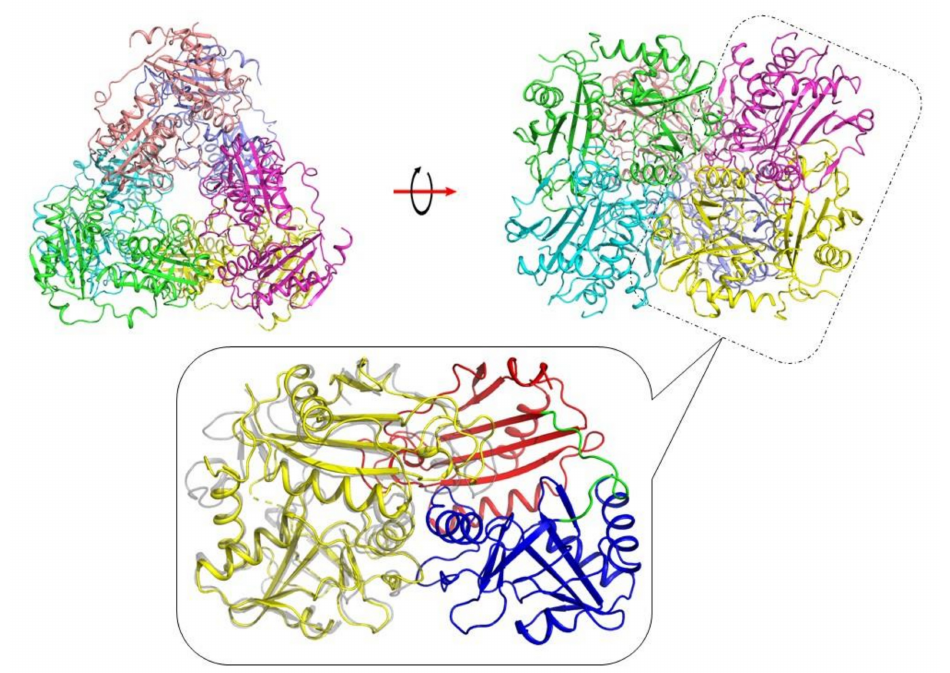
Figure 2. X-ray structure of the VP5454. ( top ) Hexamer from the asymmetric unit is colored by chains and is depicted in two projections related by a 90 ◦ rotation (red arrow). ( bottom ) A zoomed view of the functional VP5454 dimer highlighted by the dotted box in hexameric structure. Color codes are: blue—C-terminal domain, red—N-terminal domain, green—interdomain loop, and yellow—adjacent subunit of the dimer. Superposed eBCAT (PDB ID-1IYE) subunit is colored in gray and is depicted as semitransparent for